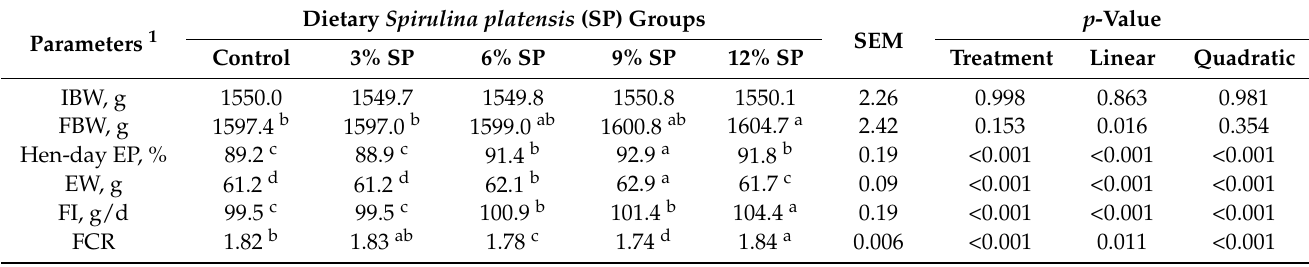
Table 3. Effect of dietary Spirulina platensis on the productive performance of laying